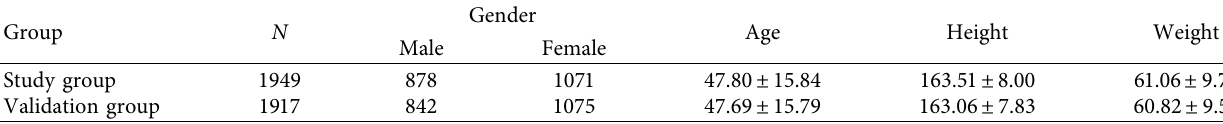
Table 1: Participants’ basic characteristics.